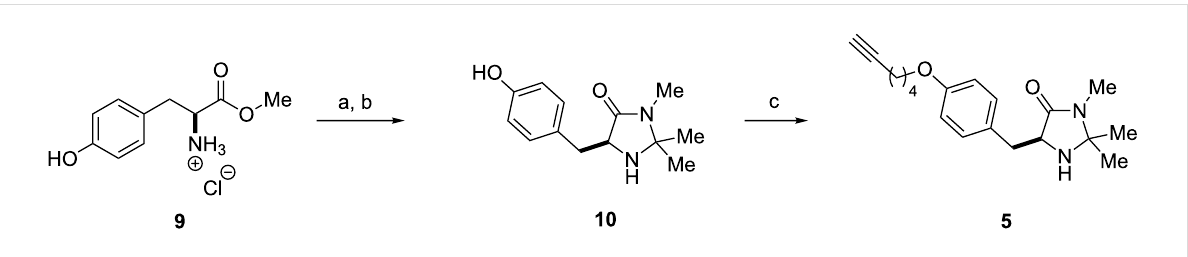
Scheme 2: Synthesis of tyrosine-based imidazolidin-4-one 5 . Reaction conditions: (a) 9 (1.0 equiv), MeNH 2 (5.0 equiv), EtOH, 25 °C, 20 h. (b) PTSA (0.01 equiv), acetone, MeOH, reflux, 18 h, 79% (2 steps). (c) 10 (1.0 equiv), NaH (1.1 equiv), 6-chloro-1-hexyne (1.3 equiv), TBAI (0.01 equiv), DMF, 25 °C, 16 h,